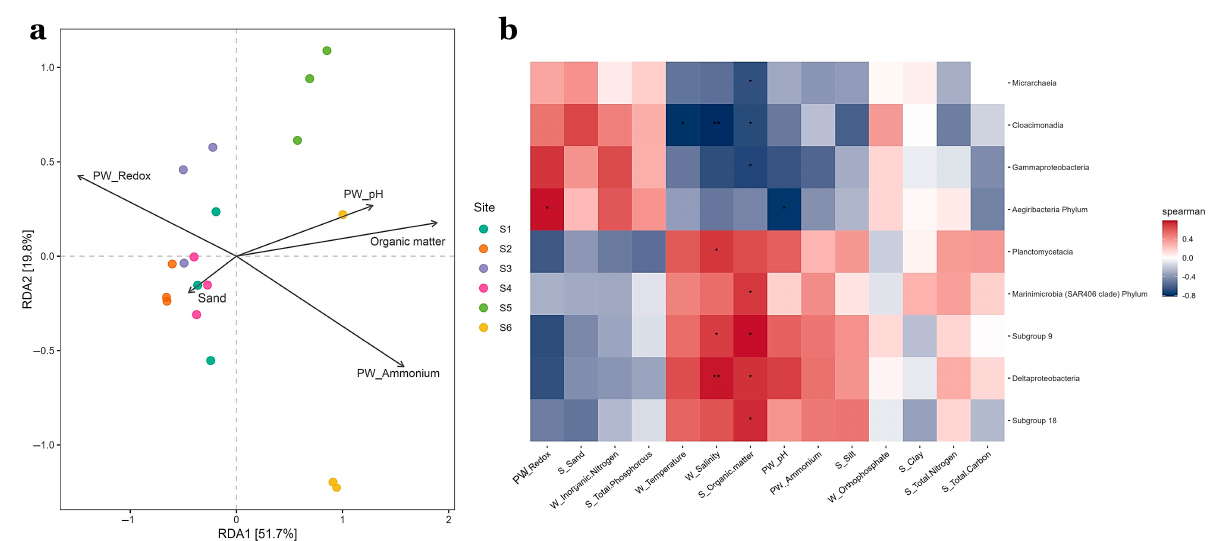
Figure 6. Distance based redundancy analysis (db-RDA) using redox potential, pH and ammonium concentration in porewater, and sand as well as organic matter content for sediments. Total variation percentages are shown for both axis ( a ). A heatmap showing Spearman’s correlations with fdr correction ( b ) between prokaryotic taxa and environmental parameters is also shown. W, PW, and S prefixes denote water, porewater and sediment determinations, respectively. A single asterisk corresponds to significant data with p -values less than 0.05 and a double asterisk correspond to p -values less than 0.01.